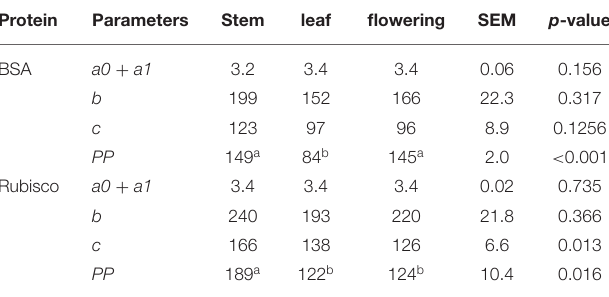
TABLE 6 | Parameters of precipitating capacities of CT from stems, leaves, and flowering heads of purple prairie clover (PPC) ( Dalea purpurea Vent) harvested at